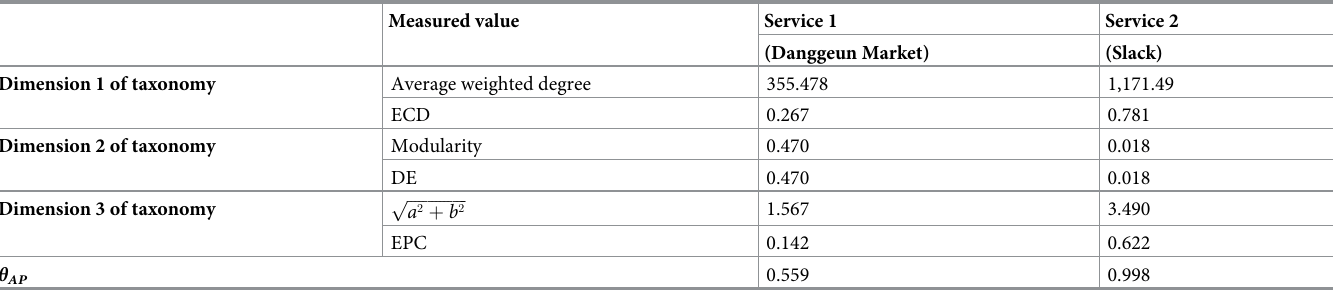
in two services with augmented-proximity (AP) AP